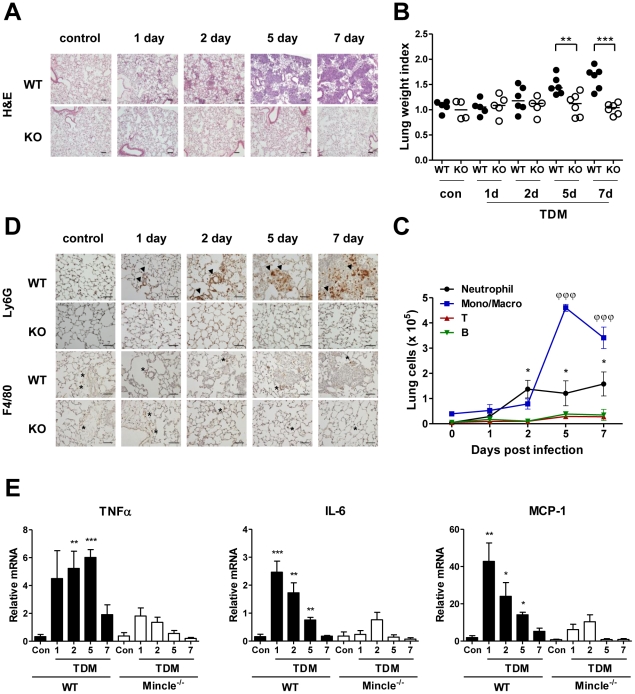
Kinetics of TDM-induced lung granuloma formation in WT and Mincle−/− mice.Wild-type (WT) and Mincle−/− mice were injected intravenously with an oil-in-water emulsion containing TDM. Emulsion without TDM was injected as a vehicle control. Mice were sacrificed at days 0, 1, 2, 5, and 7 post-TDM challenge. (A) Hematoxylin and eosin (H&E)-stained lung histology. Original magnification was 10×. Scale bars represent 100 µm. (B) Lungs from TDM-challenged mice were removed each day and inflammatory intensities were measured by calculating the lung weight index (LWI). n = 4–6 mice per group. Statistical significance: **p<0.01 and ***p<0.001. (C) Identification of leukocyte subsets in lung granulomas by flow cytometry. The number of neutrophils (CD11b+ Ly6G+), monocytes and macrophages (Mono/Macro, CD11b+ Ly6G−), T cells (CD3+), and B cells (CD19+) are indicated. Statistical significance is shown relative to day 0 for each group. *p<0.05 (in neutrophils) and ΦΦΦp<0.001 (in monocytes and macrophages). (D) Immunohistochemical Ly6G staining of neutrophils. Arrow heads indicate Ly6G+ cells near blood vessels (upper panels). Immunohistochemical F4/80 staining of macrophages. Asterisks indicate individual F4/80+ cells (lower panels). Sections are representative of 4–6 mice per group. Original magnification was 40×. Scale bars represent 50 µm. (E) TNFα, IL-6, and MCP-1 mRNA levels in whole-lung cell homogenates from WT and Mincle−/− mice following TDM administration were measured by quantitative RT-PCR. Statistical significance is shown relative to control (con) for each group. *p<0.05, **p<0.01 and ***p<0.001. Data represent means ± SEM from five independent experiments.